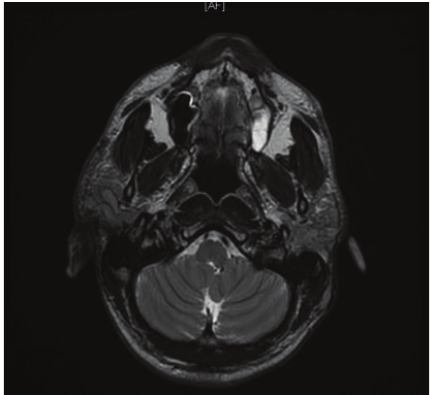
Figure 2: Preoperative MRI T2-weighted axial cut: bilateral hyper- intense enlarged parotids, with thickened overlying subcutaneous tissue.